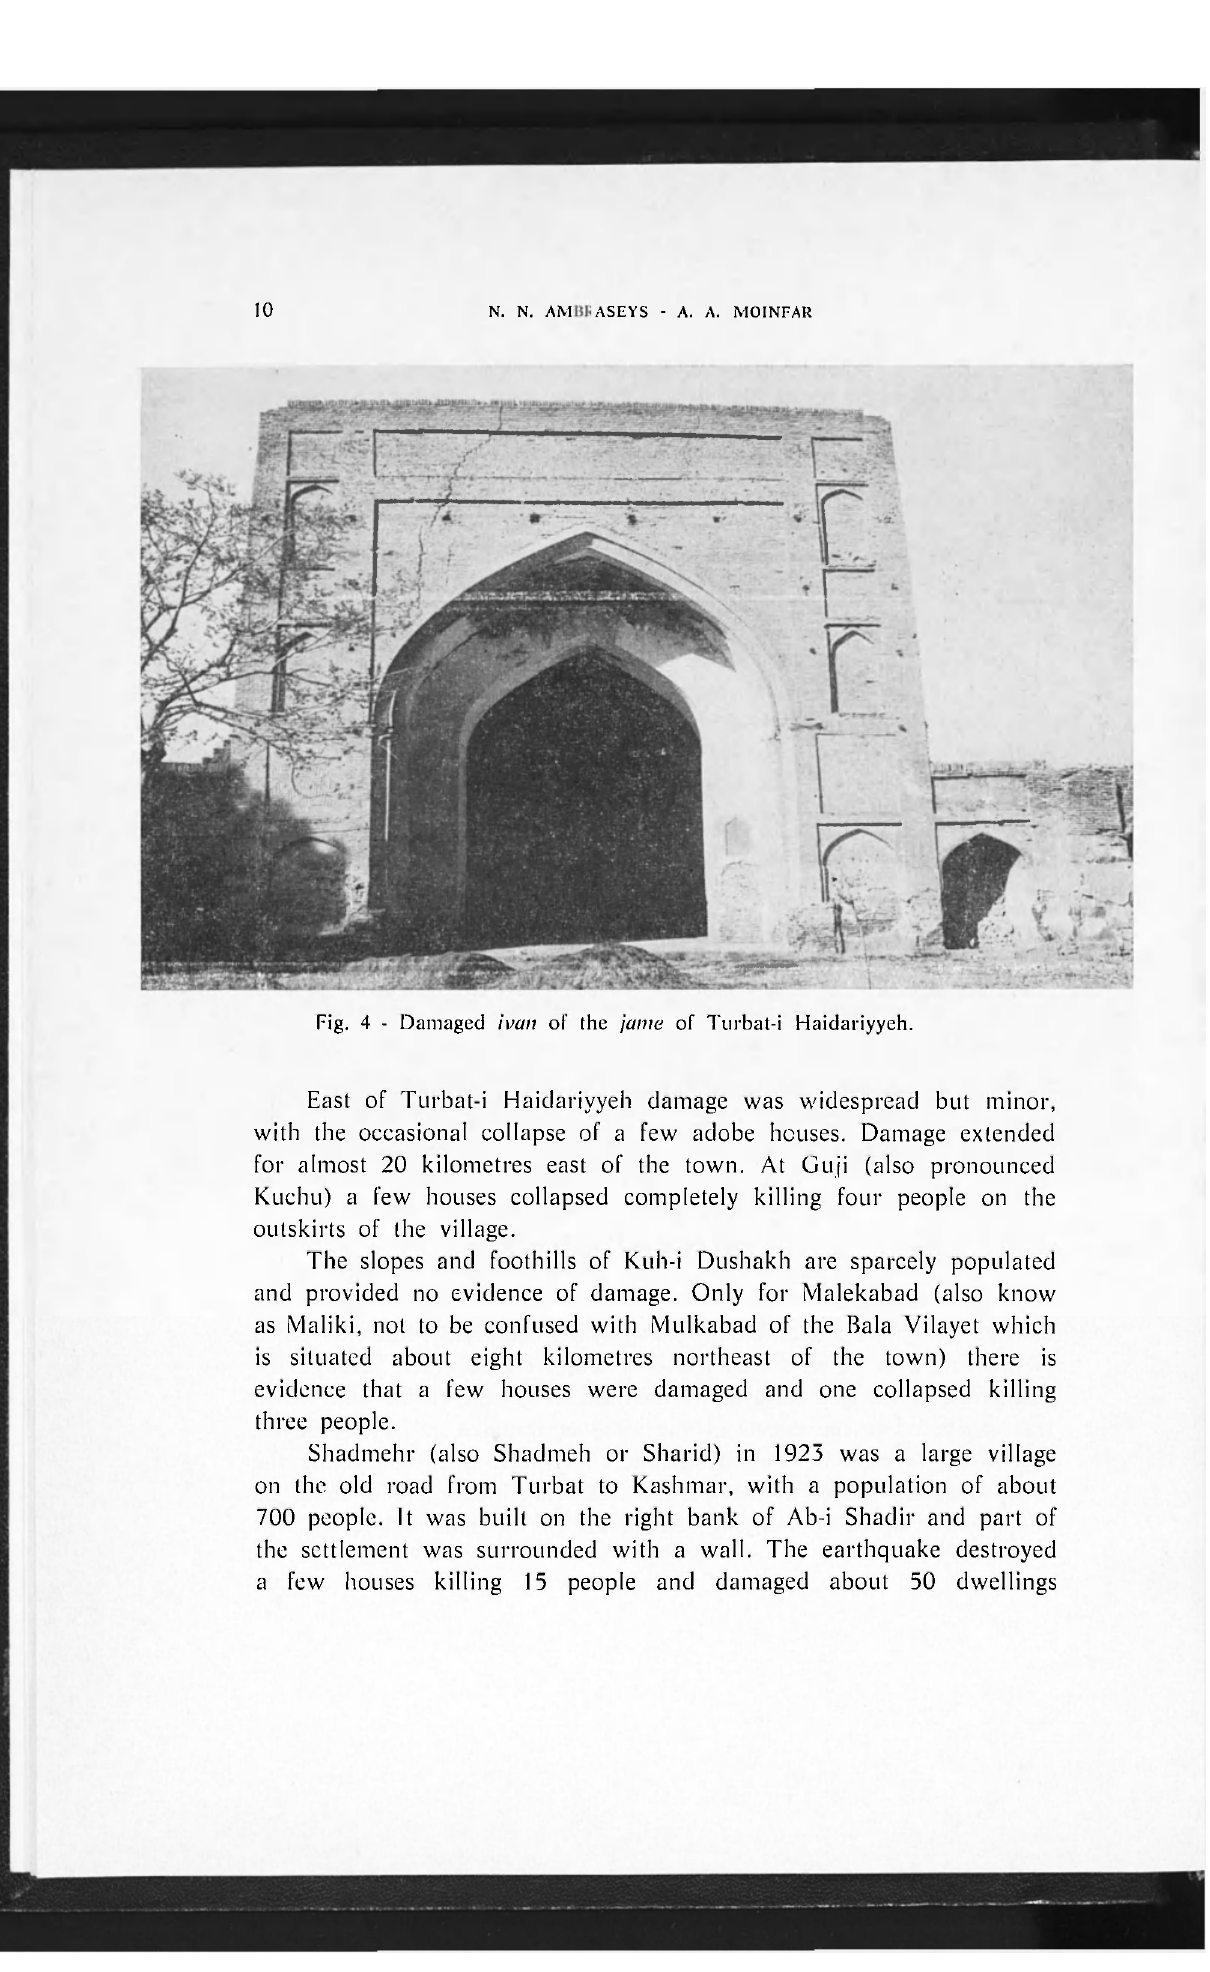
Fig. 4 - Damaged ¡van of the ¡ante of Turbat-i